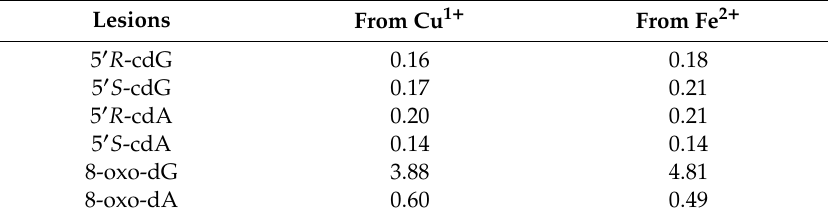
Figure 14. Kinetic study by Fenton reaction. (Left side): CuCl2 / H2O2 / Ascorbate-induced formation of 8-oxo-dG and 8-oxo-dA at 0, 20, 40, 60, 90 and 120 min. ds-(ODN5 / ODN6) treated with CuCl 2 (15 µ M), H 2 O 2 (120 µ M); (Right side): Fe 2 + / H 2 O 2 / Ascorbate-induced formation of 8-oxo-dG and 8-oxo-dA at 0, 30, 60, 90 and 120 min. ds-(ODN5 / ODN6) treated with Fe 2 + (15 µ M), H 2 O 2 (120 µ M), Ascorbate (1.2 mM). All points are the mean value ( ± standard deviation) of n = 2 independent experiments. Table 4. The line slope for each lesion obtained from the plot of the mean value of each purine lesion studied at di ff erent reaction times as reported in Figure 13 for cPu and Figure 14 for 8-oxo-Pu. Lesions From Cu 1 + From Fe 2 + 5 (cid:48) R -cdG 0.16